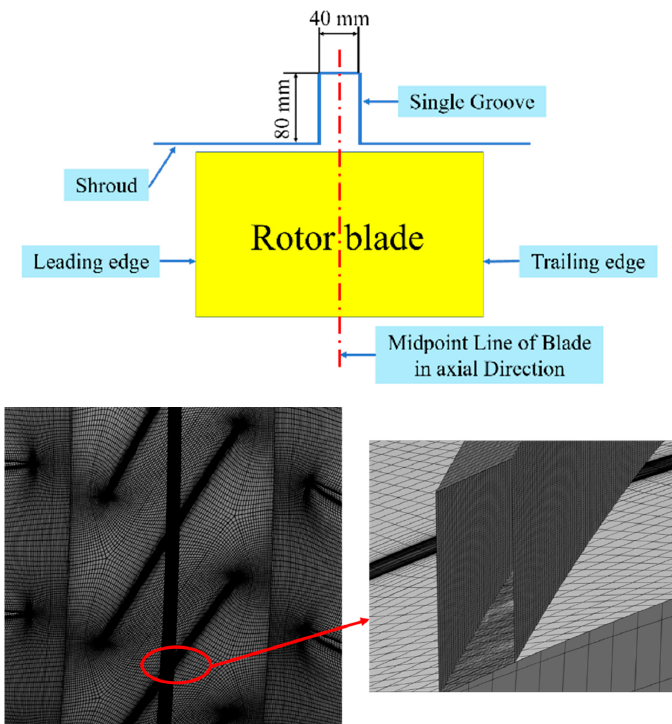
Figure 15. Sketch map of groove geometry and mesh.